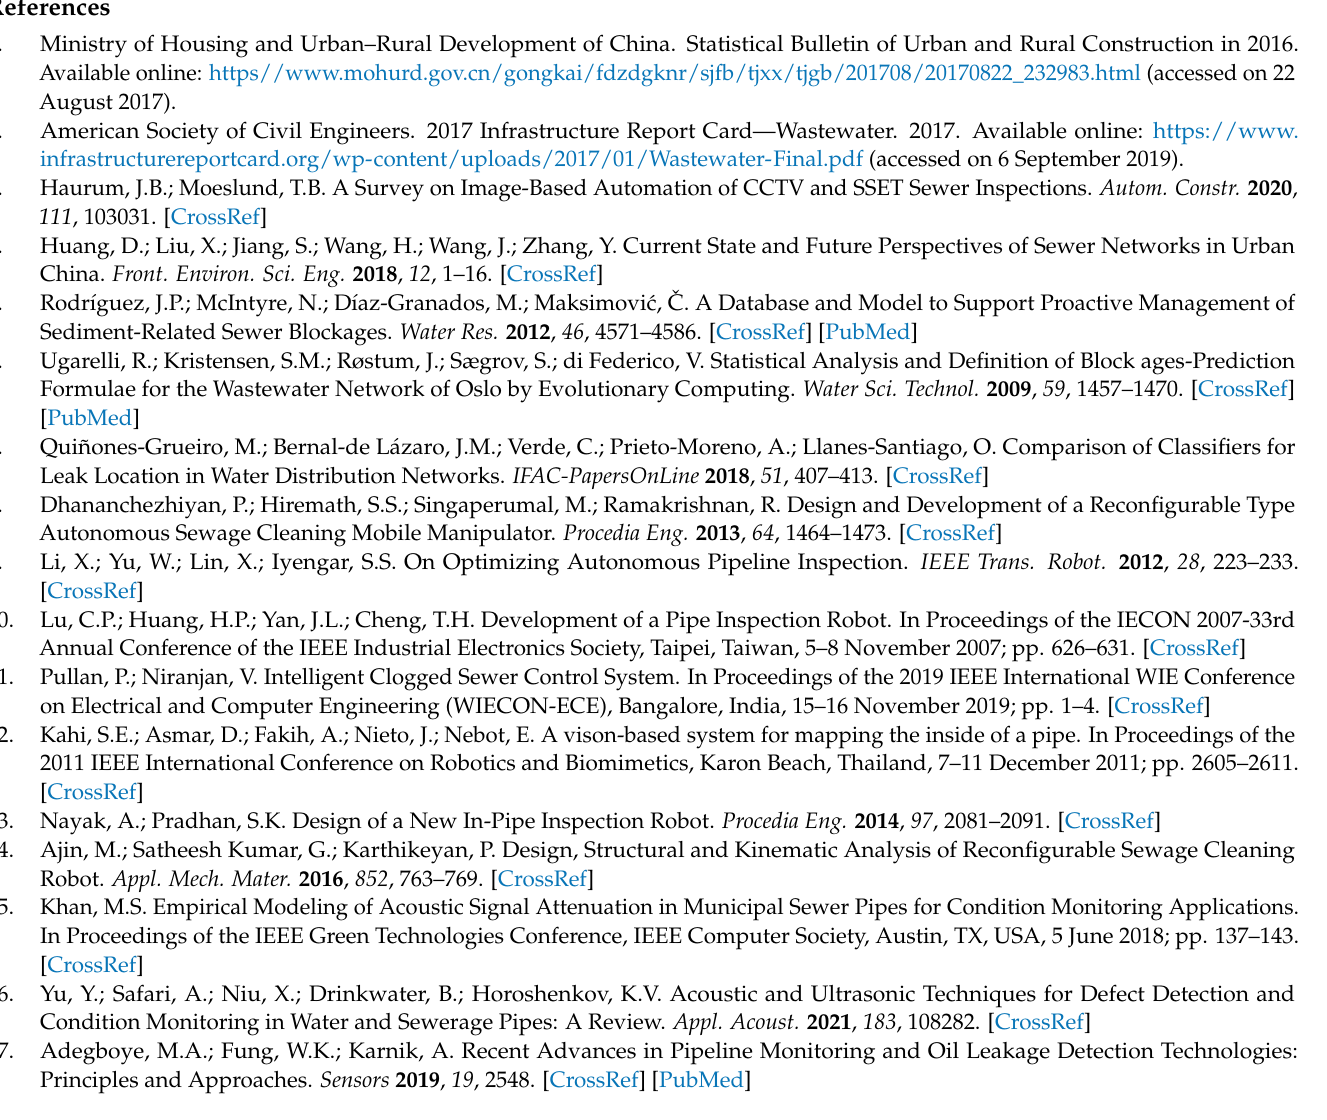
Table S2: Results of blockage identification through upstream and downstream liquid level monitoring of DN150 and DN200 drainage pipes after